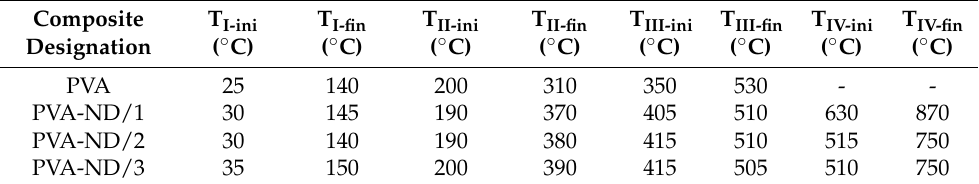
Figure 7. TGA and DTGA curves of the pure PVA. Table 2. Initial and final temperatures of the degradation step of PVA-ND